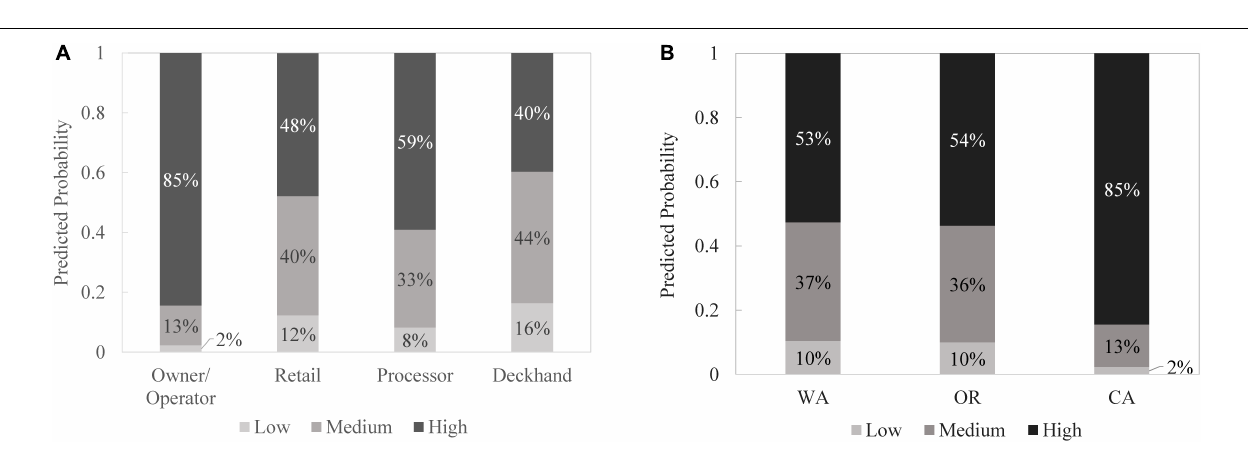
FIGURE 2 | The predicted probability of income loss level for typical fishers in California by fishing job type (A) and a typical fishing license owner/operator by State (B) .